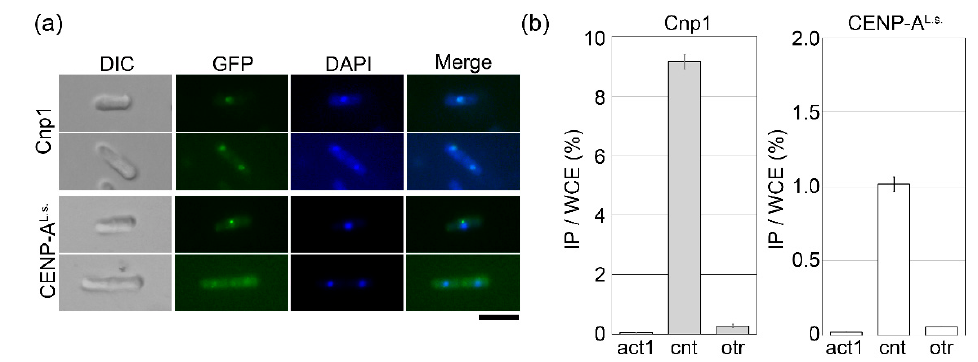
Figure 3. CENP-A L.s. can localize to the fission yeast centromere. ( a ) Wild-type cells (HM123) containing pGP8110-Cnp1 (Cnp1) or pGP4110-CENP-A L.s. (CENP-A L.s. ) were grown on minimal medium in the absence of thiamine at 33 ◦ C for 18 h, then fixed with methanol. Bar, 10 µ m. ( b ) cnp1-1 cells (Sp525) containing pGP8110-Cnp1 (Cnp1) or pGP4110-CENP-A L.s. (CENP-A L.s. ) were grown on minimal medium in the absence of thiamine at 30 ◦ C for 25 h, then fixed with 3% formaldehyde. DNA co-immunoprecipitated using anti-GFP antibodies was quantified by real-time PCR using primers that recognize the inner centromere ( cnt ) or outer centromere ( otr ) region. act1 was used as a negative control. The amount of immunoprecipitated DNA was calculated as a percentage of whole-cell extract (WCE). Error bars indicate the standard deviation from three independent experiments.